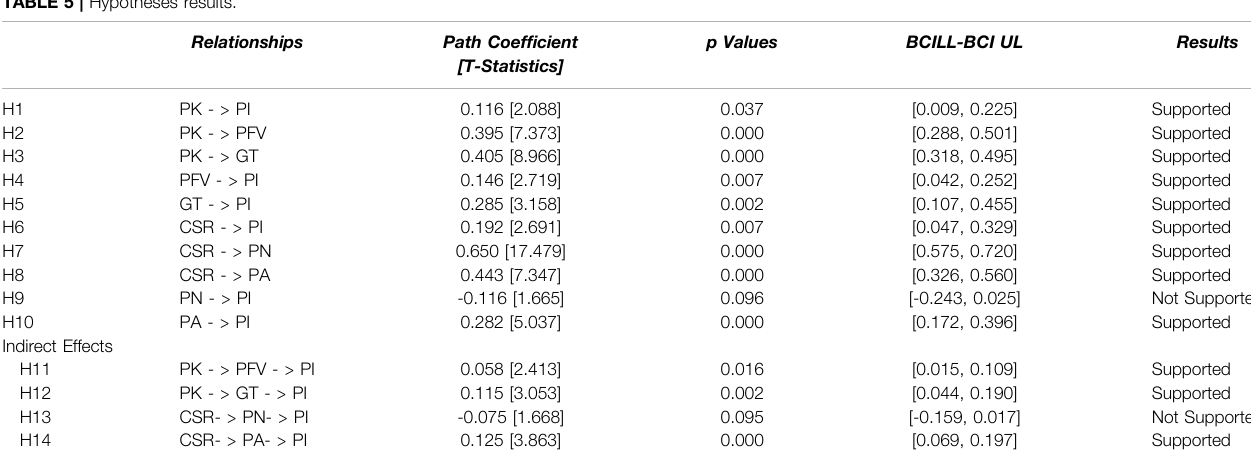
TABLE 5 | Hypotheses